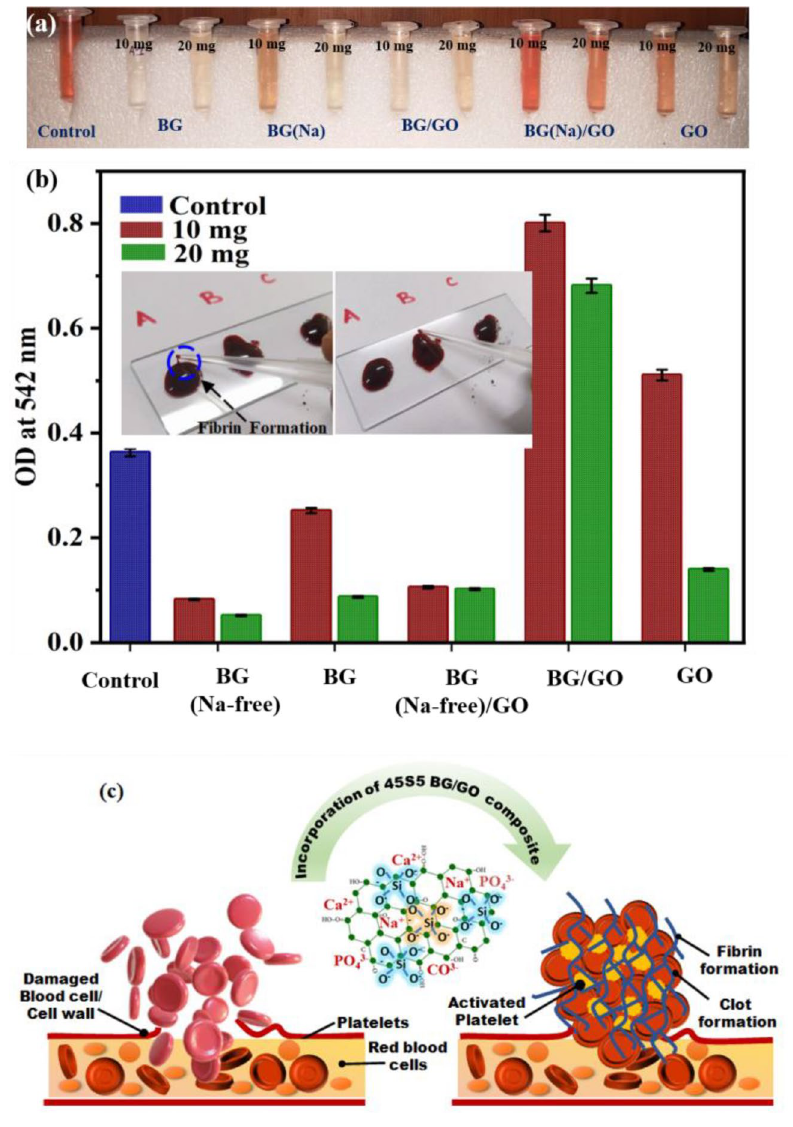
Figure 4. Hemoclot Assay of BG, BG (Na-free), GO and BG/GO, BG (Na-free)/GO nanocomposites; ( a ) photographs of supernatant collected, ( b ) optical density (O.D.) representation of hemoclot for 10 and 20 mg samples, and photographs of a blood clot with fibrin formation (inset), ( c ) schematic representation of hemostatic behavior of 45S5 BG-GO Nanocomposite.